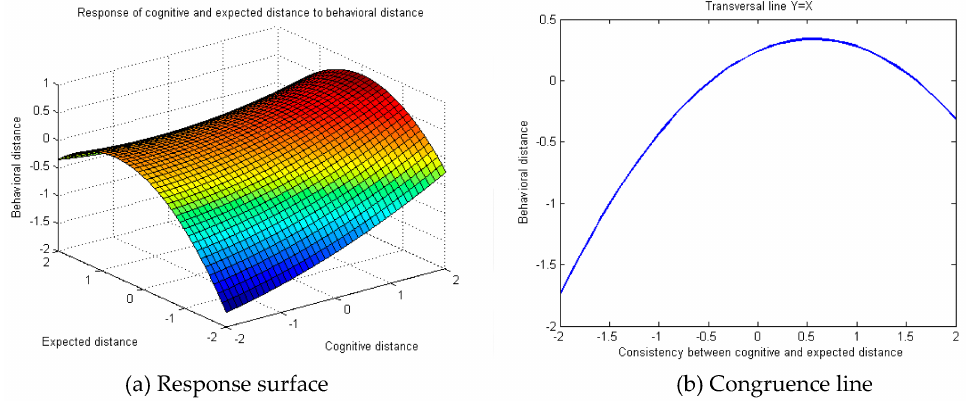
Figure 4. Response diagram of public cognitive and expected distance towards occupational safety and health against behavioral